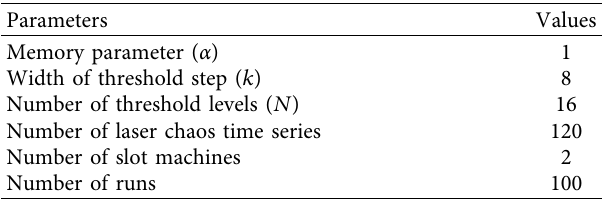
Figure 2: The autocorrelation coefficient of the laser chaos time series for different sampling intervals. Table 1: Simulation